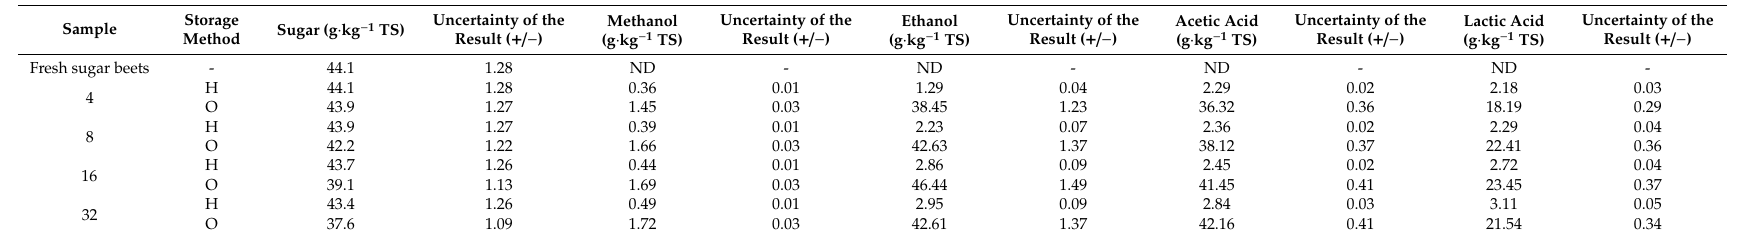
Table 3. The content of the selected chemical compounds in the samples stored—in airtight conditions and in the open-air container.